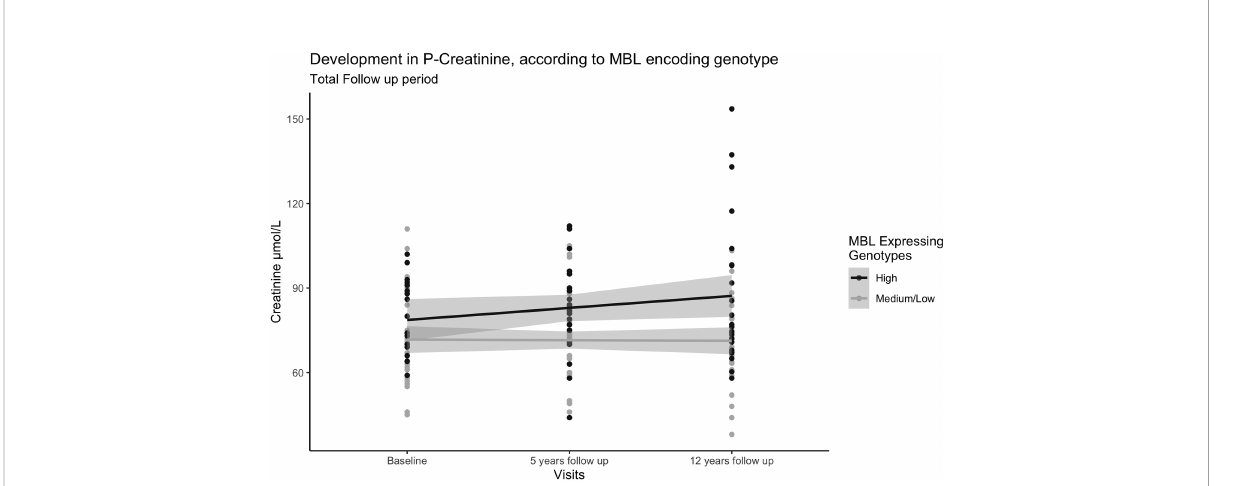
FIGURE 4 Dot plot with trend lines showing development in plasma creatinine in participants with T2D over the 12-year follow-up period. Black points represent participants with the high MBL expressing genotype (n=22) and the grey points represent participants with medium/low MBL expression genotypes (n=30). A mixed model ANOVA was performed to compare the effect of the MBL genotype on the development of plasma